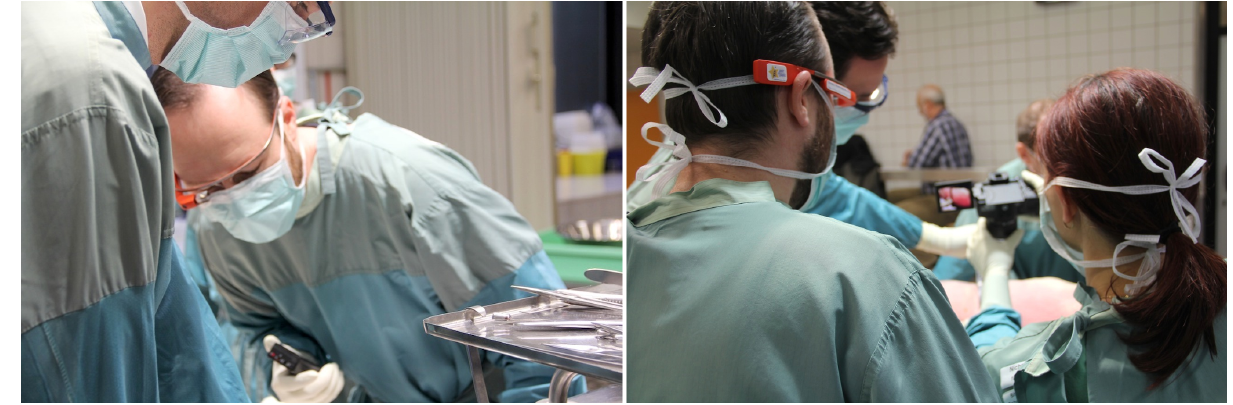
Figure 1. A typical crowded autopsy situation. On the left, the forensic pathologist is wearing Google Glass, allowing him to take pictures in a hands-free manner. On the right, the procedure is interrupted by an assistant taking a picture with a camera, which narrows the already limited space around the